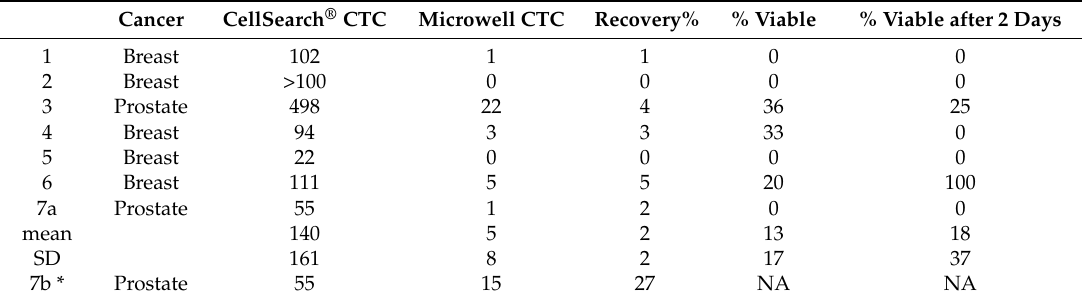
Table 2. Number of CTC in 5 metastatic breast and 2 prostate cancer patients detected in 7.5 mL of blood by CellSearch ® and in the microwells after CD45 depletion of 7.5 mL of blood and passage into the self-sorting microwells. Shown is the recovery in the microwells compared to CellSearch, also the percentage of cells that are viable inside the mcirowells. In addition the percentage of viable cells still showing viability after two days. NA is not applicable.